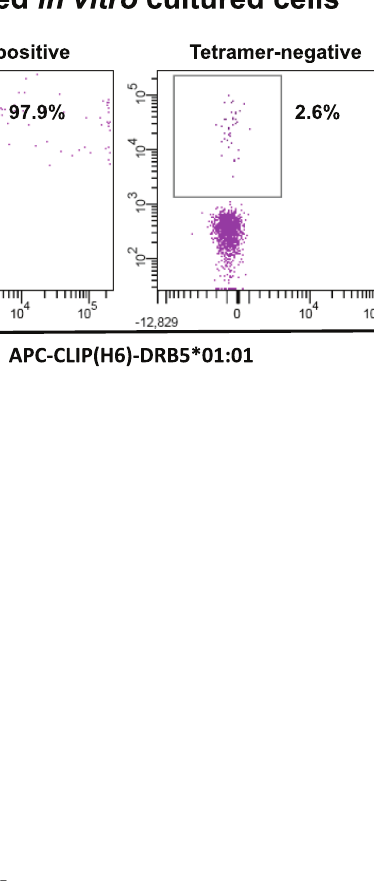
Figure 5. Exvivo MHC class II tetramer staining and sorting. Two x 10 7 PBMCs were incubated with PE- and APC-conjugated HLA-DRB5*01:01- IE1 211–225(H6) tetramers for 2 h at 37 6 C. Approximately 1000 tetramer-positive cells were isolated on FACS-ARIAII and cultured for 14 days with irradiated autologous dendritic cells pulsed with IE1 211–225 . One thousand tetramer-negative, CD4 + T cells were isolated as control and cultured under identical conditions. Following in vitro culture, tetramer-positive cells expanded to approximately 6 6 10 5 cells whereas tetramer-negative cells expanded to 10 4 cells. A) Gated tetramer-positive CD4 + T cells (encircled) shown on FACS-ARIAII following ex vivo staining. B) Dot plots showing the percentage of cells that stain with tetramer following in vitro culture of tetramer-positive and tetramer-negative sorted cells. The cells were stained with PE-conjugated HLA-DRB5*01:01-IE1 211–225(H6) (y-axis) and APC-conjugated HLA-DRB5*01:01-CLIP(H6) (x-axis). Ninety-seven point nine % of ex vivo tetramer-positive sorted in vitro cultured cells stain with HLA-DRB5*01:01-IE1 211–225(H6) (left dot plot) compared to 2.6% among ex vivo tetramer- negative in vitro cultured cells (right dot plot). No staining with irrelevant tetramer can be observed in either population. C) ICS of in vitro cultured tetramer-positive cells stimulated with IE1 211–225 –pulsed irradiated autologous dendritic cells. Ninety-four % produce cytokine (IFN- c and TNF- a ) and up regulate